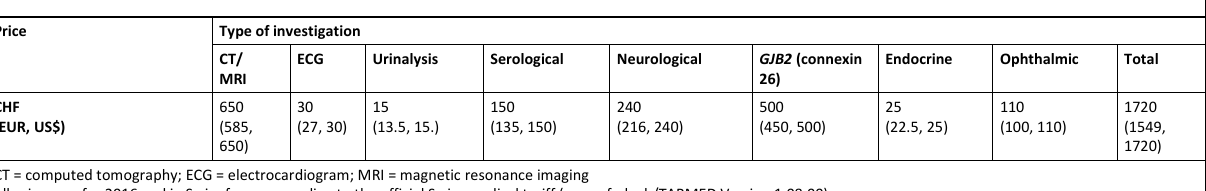
Table 5: Costs of investigations. Price